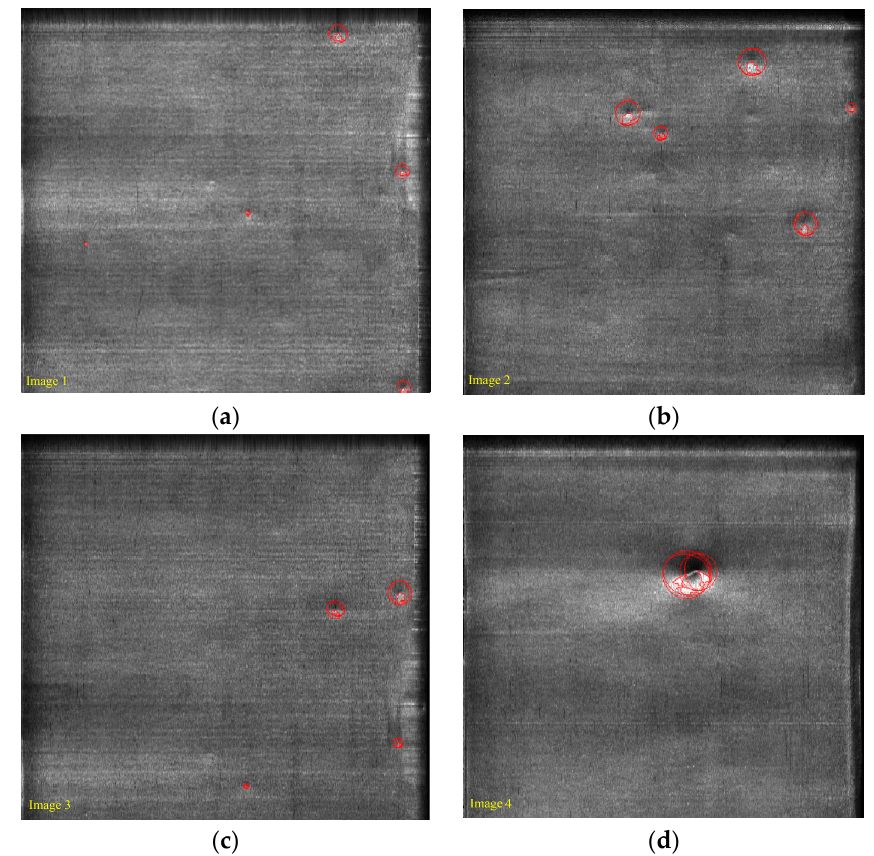
Figure 13. The inspection results of defects for concave and convex based on sub-regional Gaussian and MAF, where N = 512. ( a ) Inspection result of defects for concave and convex on image 1; ( b ) Inspection result of defects for concave and convex on image 2; ( c ) Inspection result of defects for concave and convex on image 3; ( d ) Inspection result of defects for concave and convex on image 4. Table 1. Accuracy rates and detection time comparison of partition and traditional unpartitioned detection results.